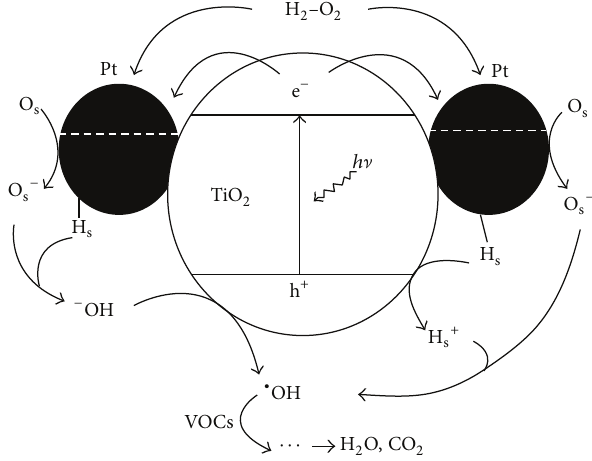
Figure 5: Proposed mechanism for the photochemical generation of dOH radicals on a Pt/TiO 2 catalyst in the coexistence of H 2 and O 2